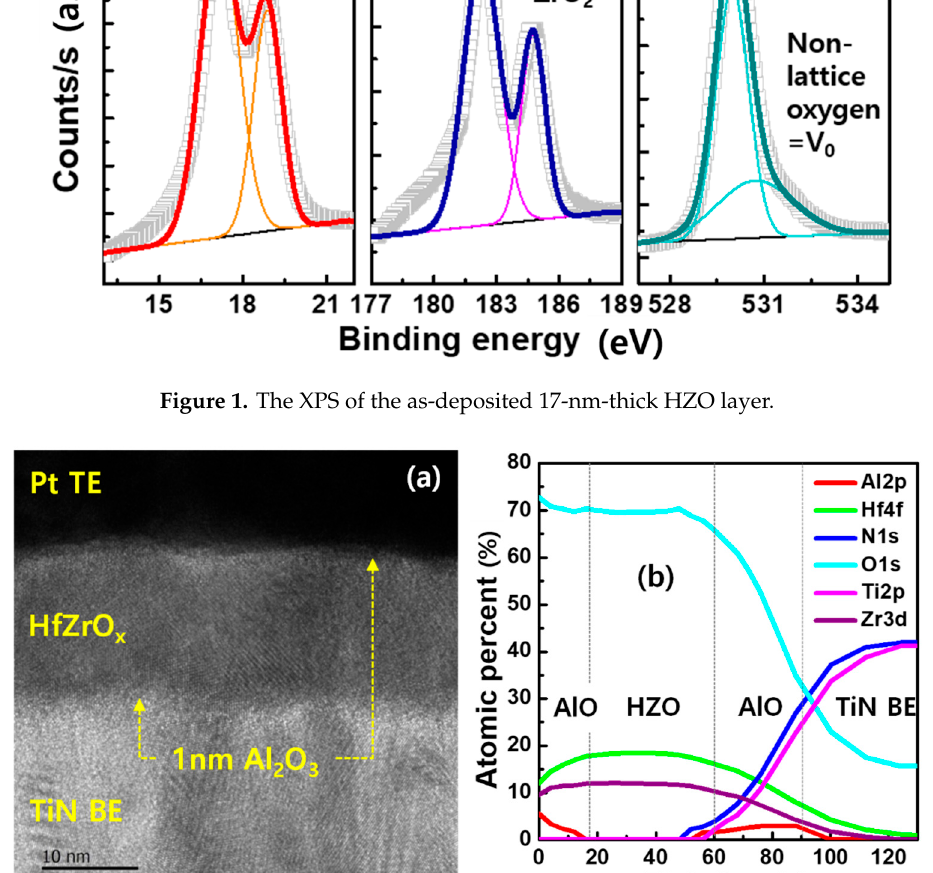
Figure 2. ( a ) Cross-sectional TEM image of the trilayer AlO / HZO / AlO structure. The crystallized phases were shown in the HZO. ( b ) XPS depth profile of the trilayer. The Al peaks were detected at the both interfaces.